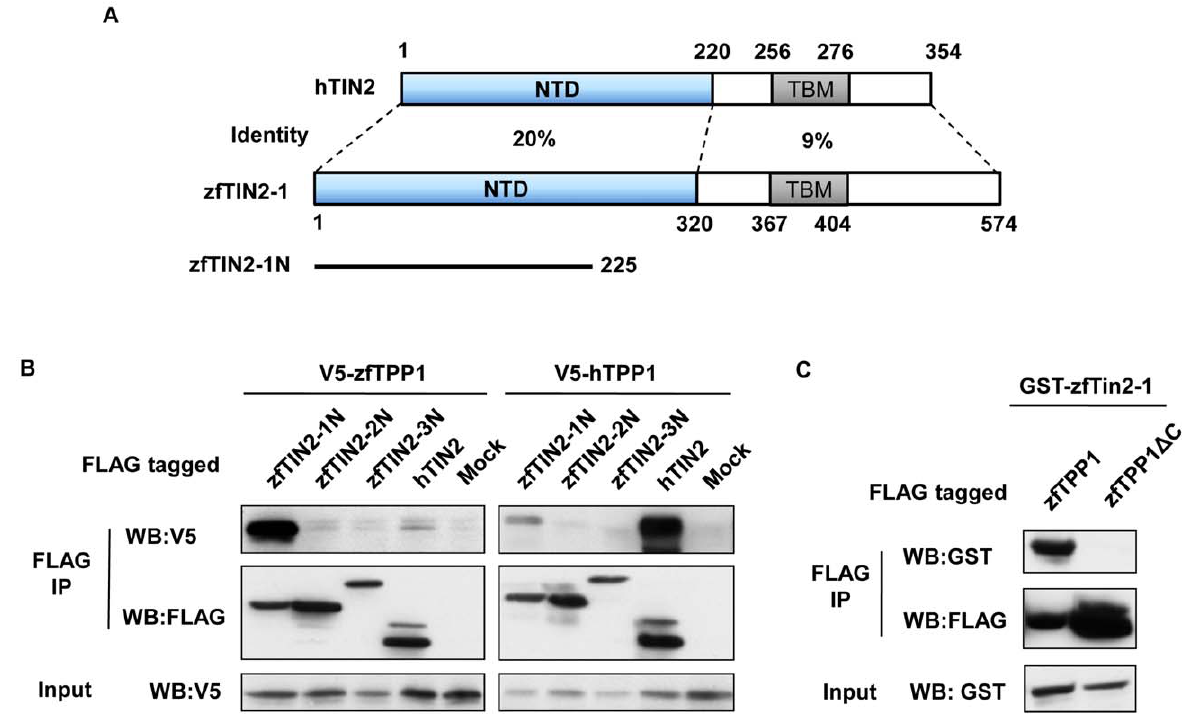
Figure 4. zfTPP1 interacts with zfTIN2-1 through its C-terminus. (A) Schematic representation of domain homology between human and zebrafish TIN2. NTD, N-terminal domain. TBM, TRFH-binding motif. (B) zfTPP1 interacts with zfTIN2-1. Extracts from 293T cells co-expressing V5- tagged zfTPP1 or hTPP1, together with FLAG-tagged N terminal part of zfTIN2-1, zfTIN2-2, or zfTIN2-3, were immunoprecipitated with anti-FLAG antibodies and western blotted. FLAG-tagged hTIN2 was also included. (C) The C terminal domain of zfTPP1 mediates its interaction with zfTIN2-1. Extracts from 293T cells co-expressing GST-tagged full-length zfTIN2-1 with FLAG-tagged full-length zfTPP1 or zfTPP1- D C were analyzed by immunoprecipitation and western blotting.